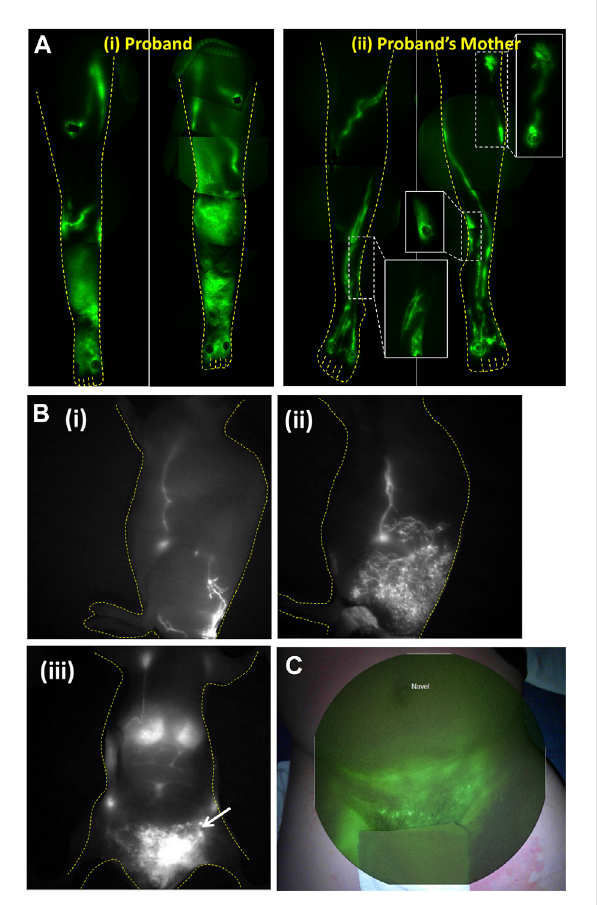
FIGURE 8 (A) Montages of the lower extremities of (i) proband diagnosed with primary lymphedema and (ii) her symptomatic mother demonstrating well-de fi ned lymphatics but with dysfunctional dermal back fl ow expanded in fi gure inserts. The aberrant imaging phenotype enabled discovery of CELSR1 as a causal gene variant associated with non-syndromic lymphedema. Reproduced with permission from (Gonzalez-Garay et al., 2016). (B) Lymphatic imaging of (i) lateral lymphatic draining from base of tail to inguinal and axillary lymph nodes in WT mouse, (ii) same lymphatic watershed in asymptomatic animal with RASA1 insuf fi ciency, that progressed with (iii) chylous ascites as seen by arrow in ventral view. Reproduced with permission from (Burrows et al., 2013). (C) NIRFLI overlaid on white light to show lymphatic drainage into groin and pelvic region with lymphoceles displaying bright fl uorescence in a patient with RASA1 mutation. Reproduced with permission from (Burrows et al.,